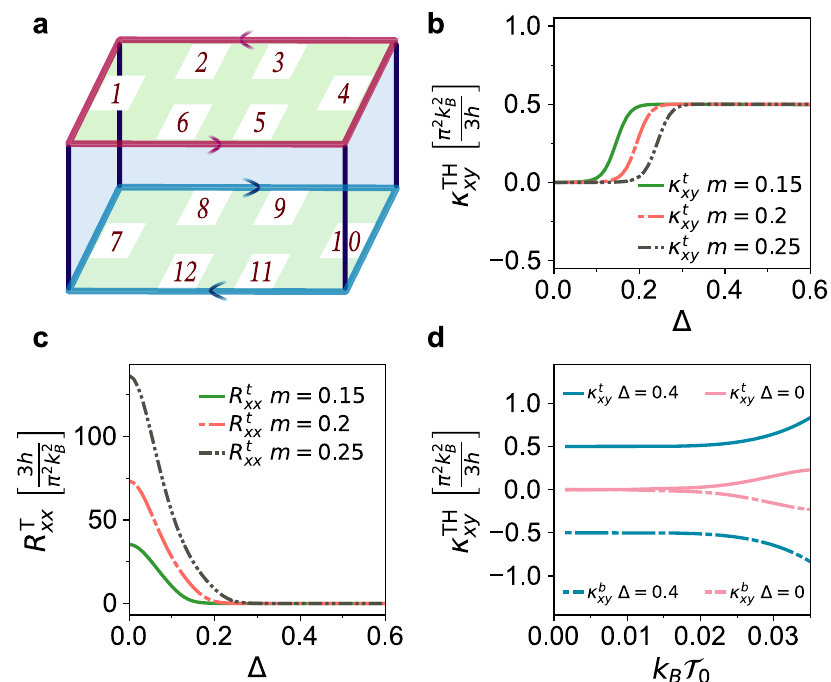
Fig. 4 Quantized thermal transport signature to identify the axion insulator. a Schematic diagram for a cubic axion insulator device with six metallic leads on the top or bottom, respectively. Magnetization of all the surfaces points outwards and top and bottom surfaces are covered by s − wave superconductors. b and c The normalized thermal Hall conductance κ TH xy and longitudinal resistance R T xx as functions of pairing potential Δ with m = 0.15, = 3 h and R T 0.2, and 0.25. For Δ > ∣ m ∣ , κ TH xy exhibits precise half-quantized value in the unit of π 2 k 2 xx remains zero. d Thermal transport properties as a B function of the background temperature T 0 with Δ = 0 and Δ = 0.4. Here, m = 0.2. Solid or dashed lines represent the top ( t ) or bottom ( b ) surfaces. The size of the cubic is L x = 50, L y = 30, L z = 20, and other parameters can be found in Supplementary Note